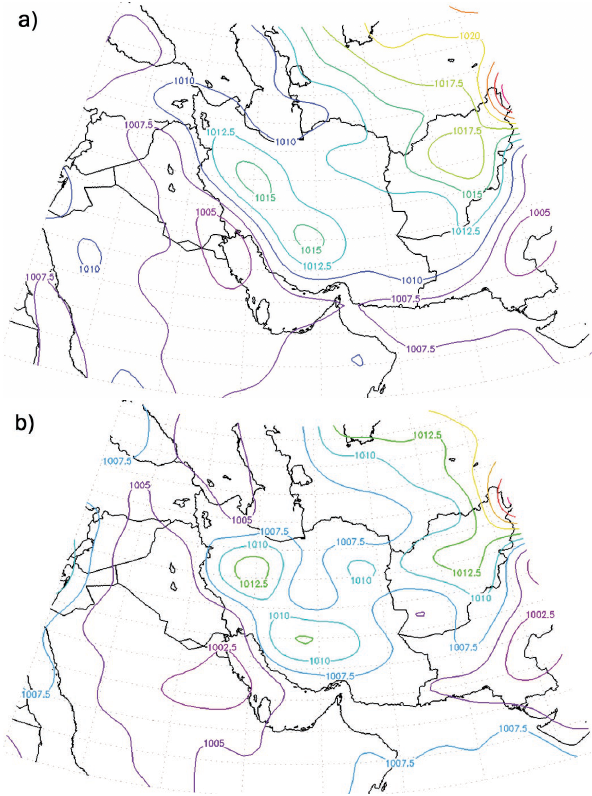
Fig. 5. (a) 850hPa chart include contours with 40m and isotherms with 2.5 ◦ C intervals, respectively, on 30 April 2009 at 00:00UTC. (b) 850hPa chart include contours with 40m and isotherms with 2.5 ◦ C intervals, respectively, on 30 April 2009 at